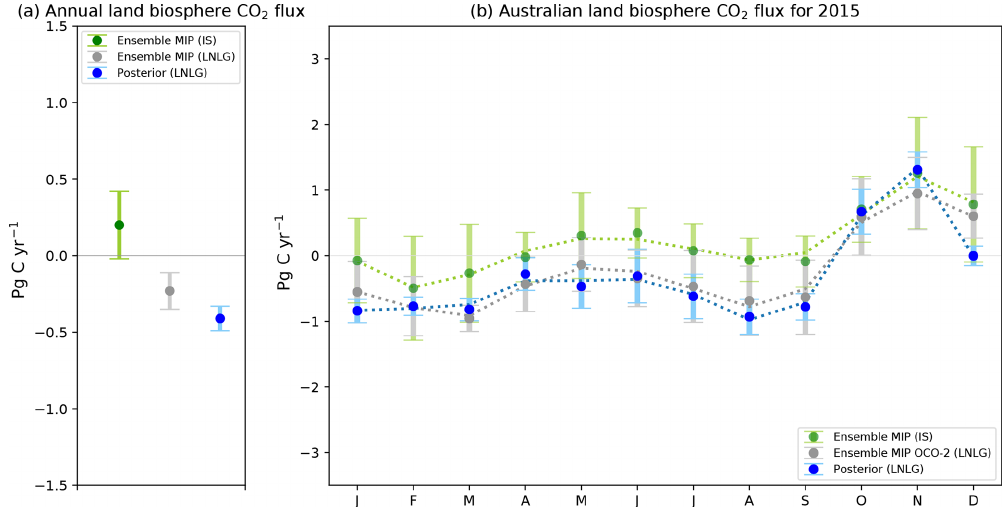
Figure 15. As in Fig. 14, but in this case, the monthly mean posterior flux (blue dot) for July has been interpolated between June and